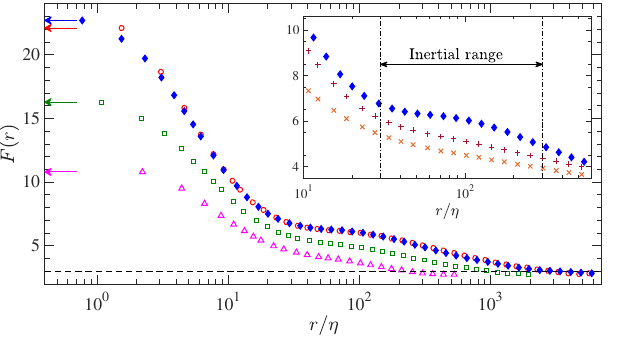
FIG. 11. The peak magnitude of logarithmic local slope of circulation flatness in the inertial range, plotted against R λ . The solid line is a least-squares fit. If extrapolated, the minimum of the logarithmic derivative will reach zero, corresponding to constant flatness in Fig. 10, at R λ ≈ 1900 . The data of Ref. [13] at R λ ¼ 216 (filled square) are shown for comparison. Inset shows the logarithmic local slopes of circulation flatness as a function of r= η , up to r ∼ O ð L Þ for R λ ¼ 1300 (upside down triangle) and R λ ¼ 240 (circle). Error bars indicate 95% con- fidence